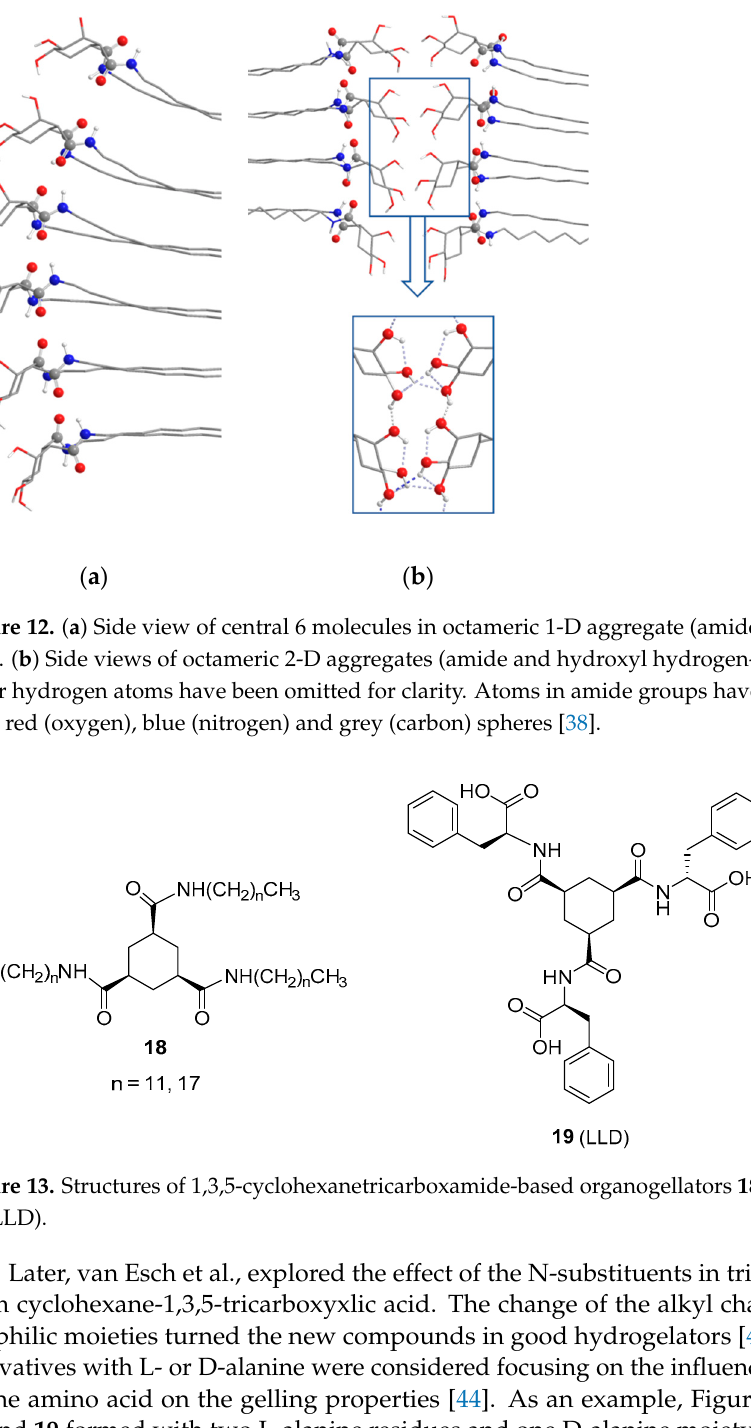
Figure 14. Structure of cyclohexane-based bis(acyl-semicarbazide) gelators 20 and photograph of the multiple switching process of the C 12 -organogellator under the alternate effects of ultrasound, temperature and anions. Adapted with permis- sion from ACS [45].